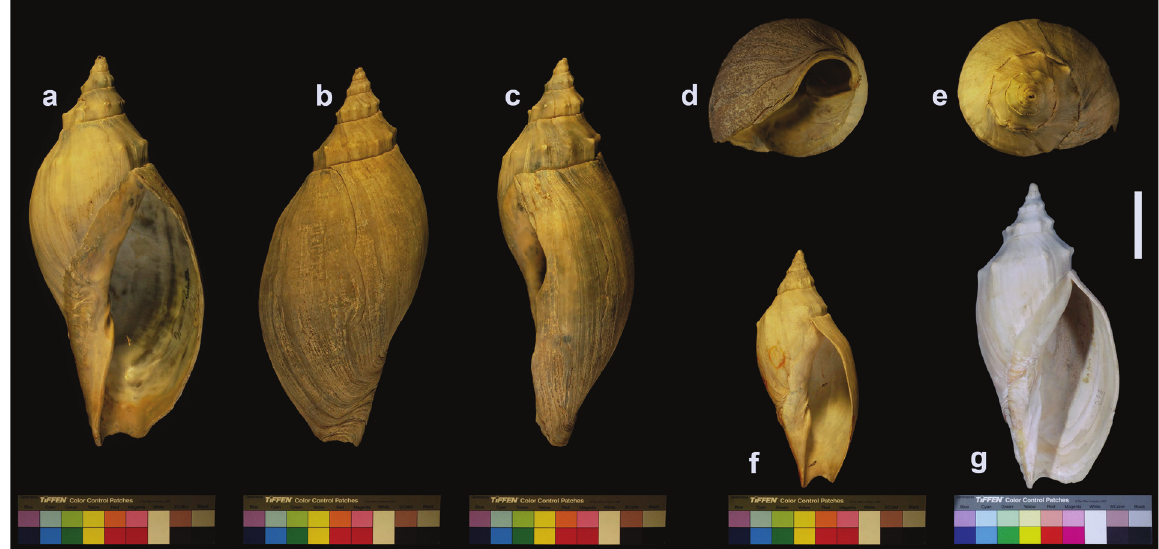
Figure 38. Specimens of Voluta fusiformis typica . a–e Specimen 1 a Apertural view b Dorsal view c Lateral view d Umbilical view e Apical view f Specimen 2 g Specimen 3. Scale bar: 5 cm.